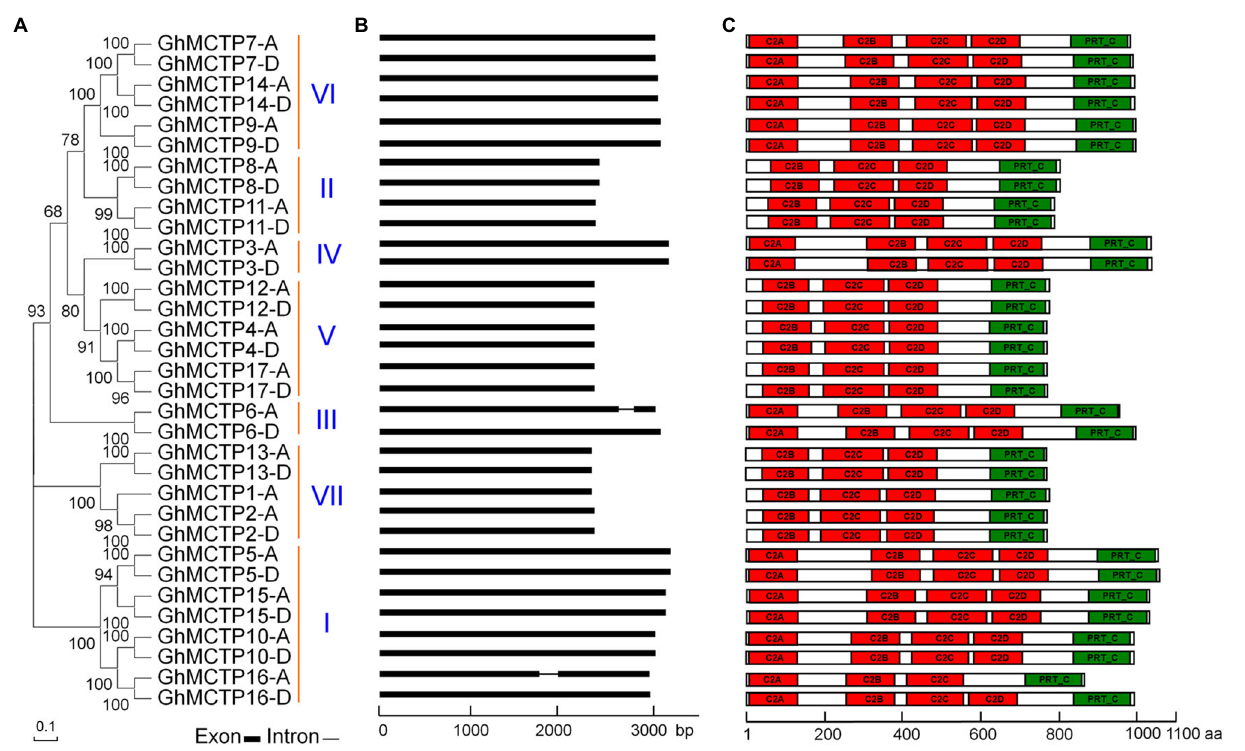
FIGURE 1 | Characterization of multiple C2 domain and transmembrane region proteins ( MCTP ) family proteins in upland cotton ( Gossypium hirsutum ). (A) Thirty- three GhMCTP proteins are classified into seven groups based on phylogenetic analysis of MCTP proteins in G. hirsutum . The phylogenetic tree was generated with MEGA X using the neighbor-joining algorithm. Numbers on the major branches indicate bootstrap values (>50%) in 1,000 replicates. (B) Schematic diagrams showing the gene structures of GhMCTP genes. The coding regions are indicated by black boxes. The intron is represented by a black line. (C) Protein motif analysis of GhMCTPs. The prediction of protein motifs is based on InterProScan. C2 domain and Phosphoribosyltransferase C-terminal are labeled as red and green boxes, respectively. bp, base pair; aa, amino